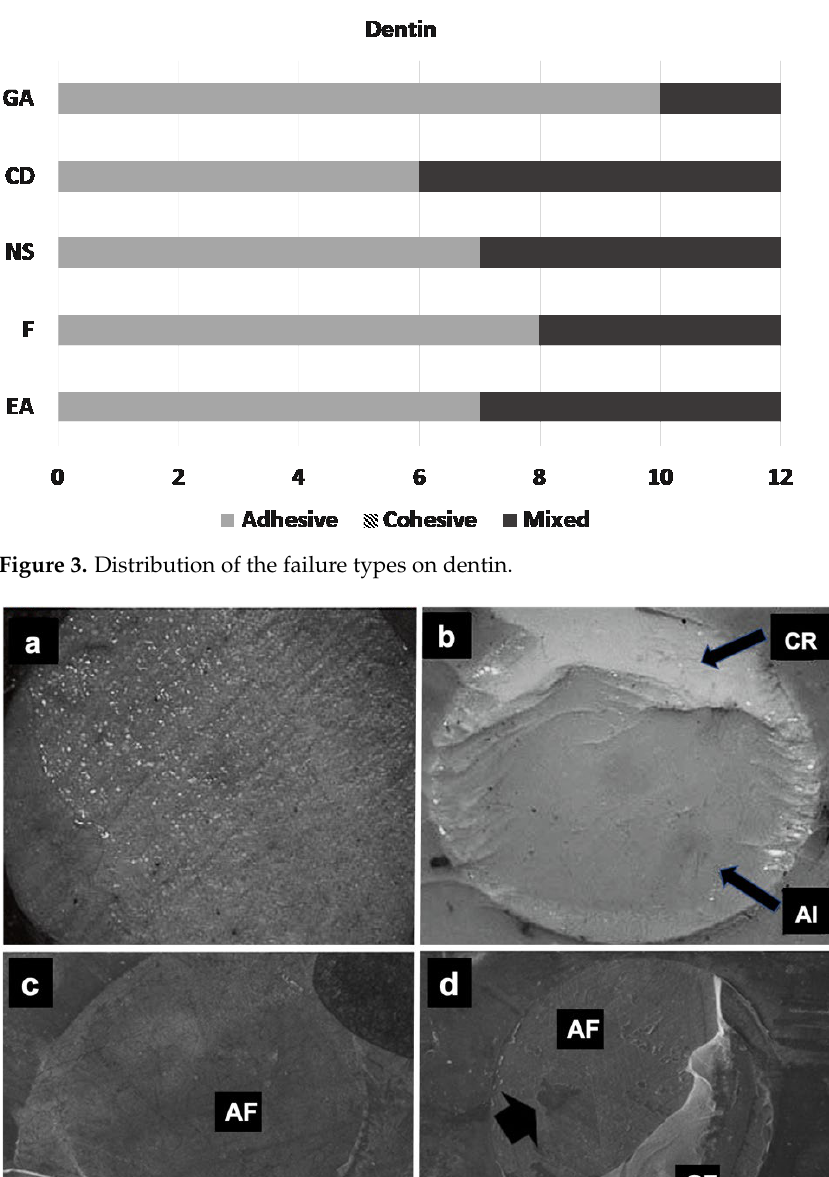
Figure 2. Distribution of the failure types on enamel.